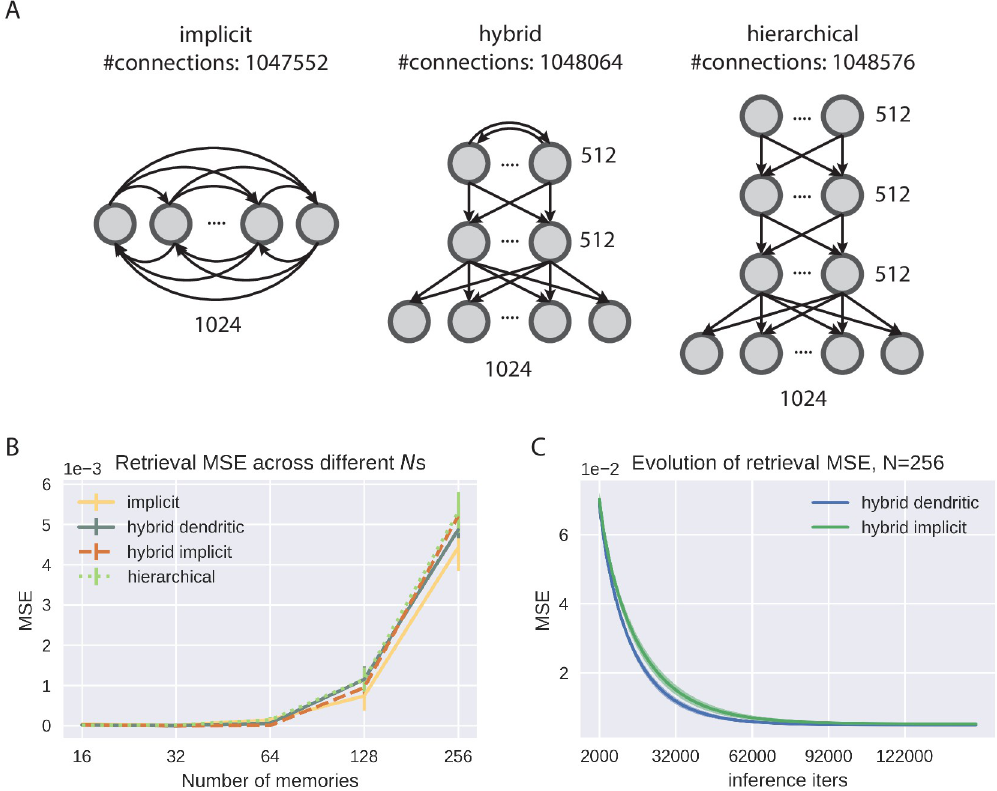
Fig 5. Performance of the multi-layer models. A: Demonstration of how we keep the number of parameters across different models to be roughly the same. B: Retrieval mean squared errors (MSEs) of the multi-layer models across multiple numbers of training memories ( N ). The curve for the implicit model is the same as the one in Fig 4. C: Evolution of the retrieval MSEs of the implicit and dendritic hybrid models when N = 256. Error bars obtained by 5 different seeds for image